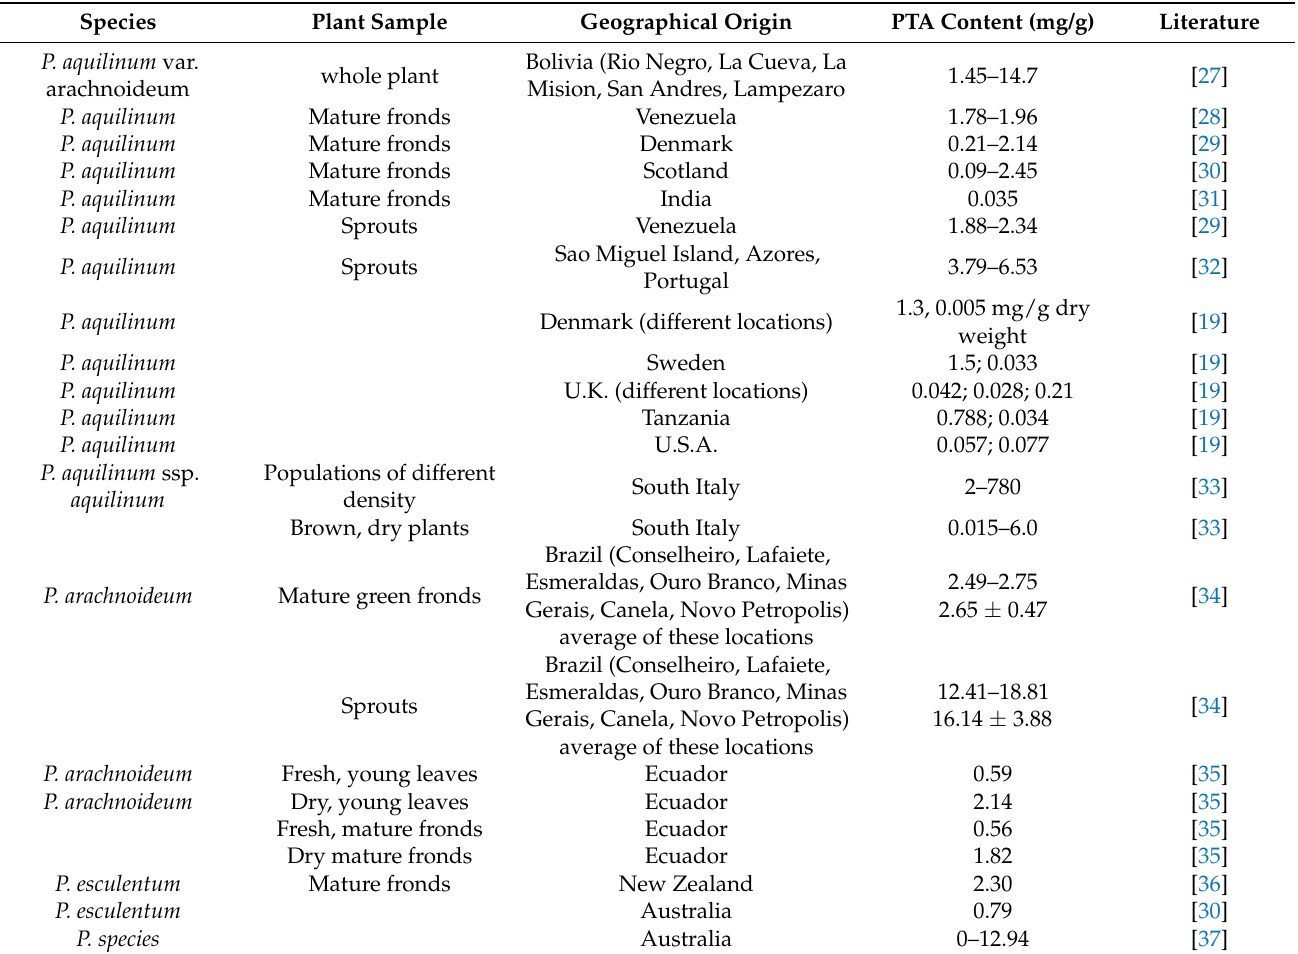
Table 3. PTA contents in Pteridium